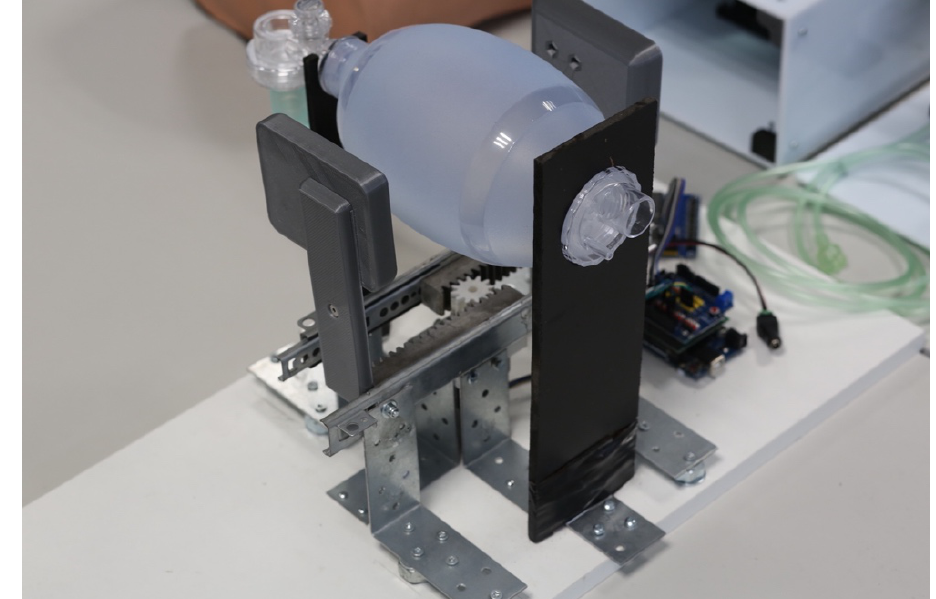
Fig. 2. First demonstration prototype assembled in 3